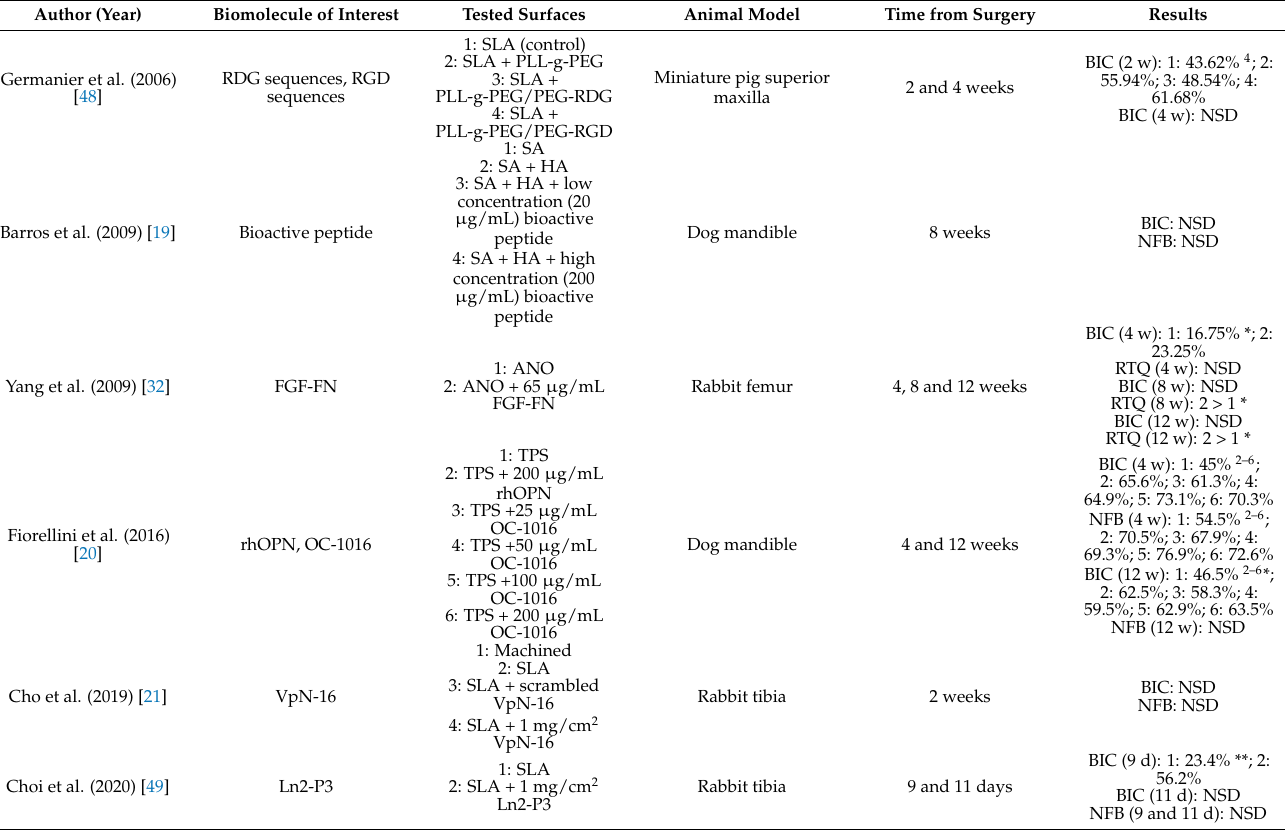
Table 2. Peptides: results from the considered